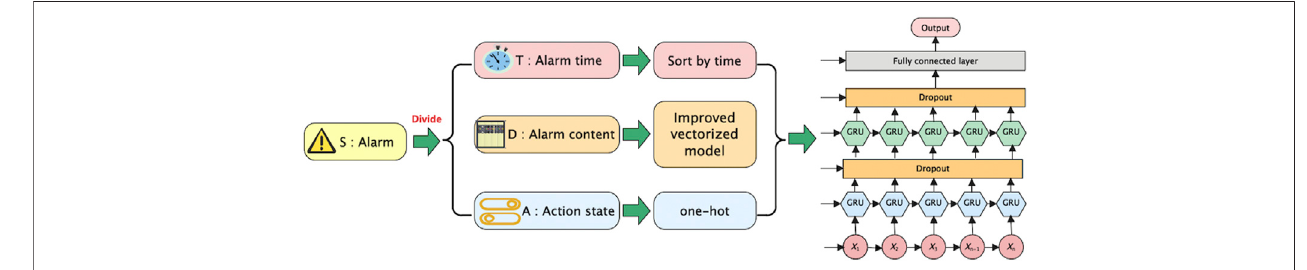
FIGURE 3 | Monitoring event recognition